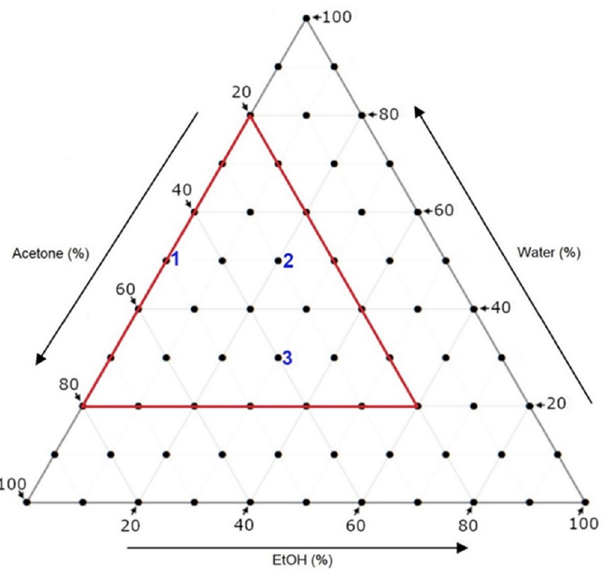
Figure 3. Ternary diagram with 1 , 2 and 3 (in blue) to indicate the optimal solvent systems for extracting the corresponding flavonoids from Sauvignon blanc pomace as previously identified in the literature [30] and the range of solvent systems (outlined in red) that were trialed in this study for extracting the three flavonoids from Pinot noir pomace.